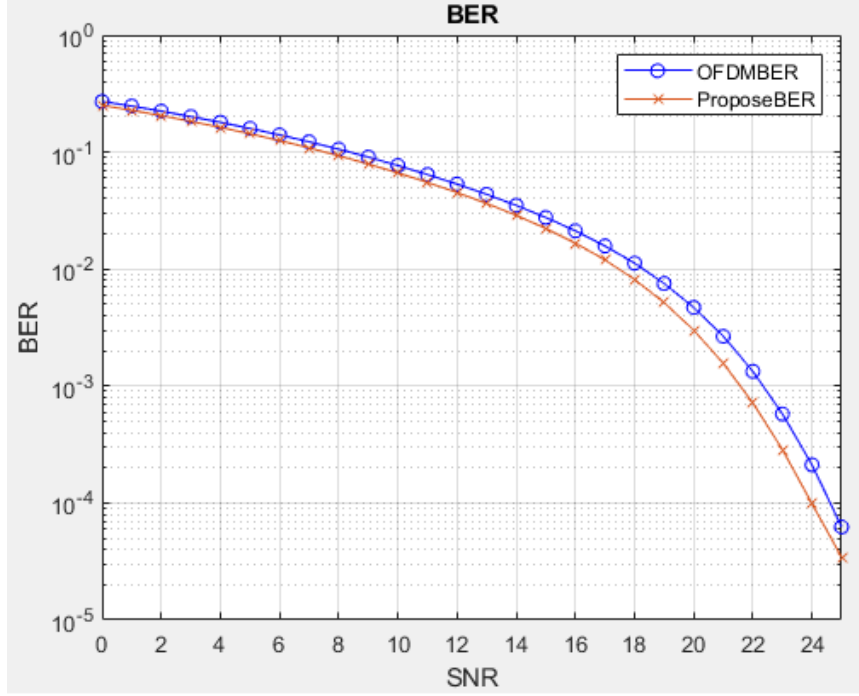
Figure 15. BER vs. SNR with OFDM and proposed